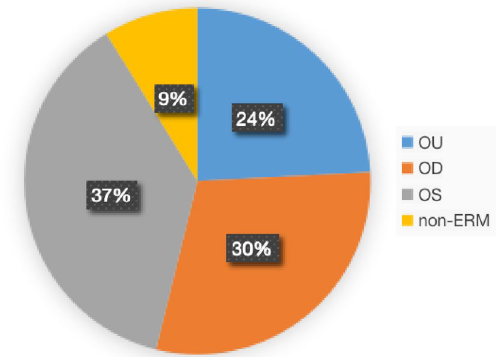
Figure 3. Rate of affected eyes in recruited population. The above pie chart illustrated composition of recruited population in terms of different affected eyes diagnosed by OCT. Among 91 patients with their OCT images re-examined by ophthalmologists, 22 patients were diagnosed with ERM in both eyes; 27 were diagnosed with right-eye ERM only; 34 were diagnosed with left-eye ERM only; 8 were confirmed as non-ERM. Percentages of each kind were labeled next to its corresponding sector on the chart.